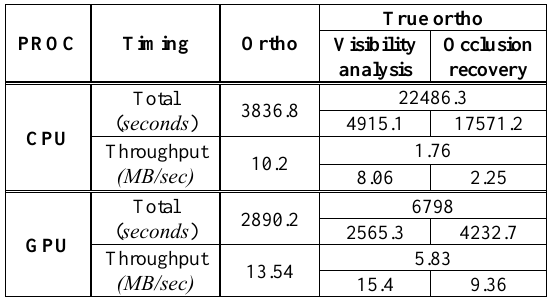
Table 2. Processing statistics